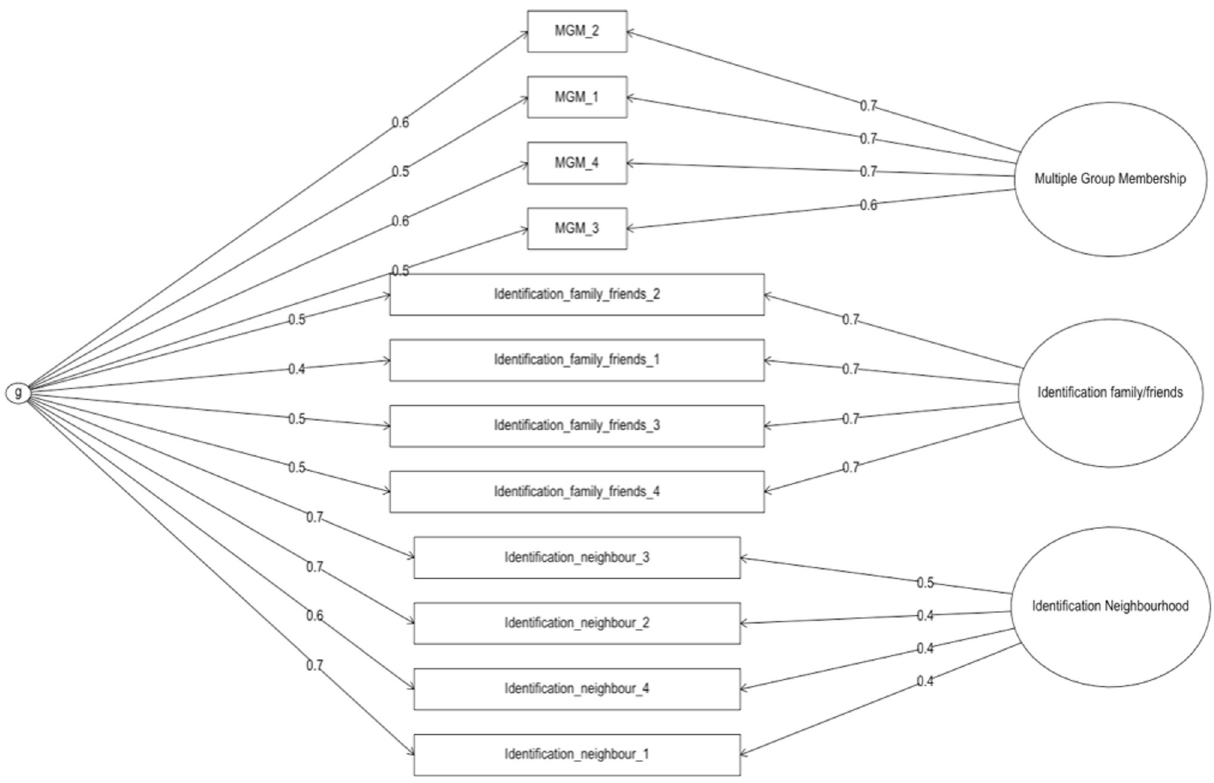
Fig 1. Bi-factor structure of measures in Study 1b. Item names correspond to measures listed in Table 1 respectively. Numbers on arrows represent factor loadings.